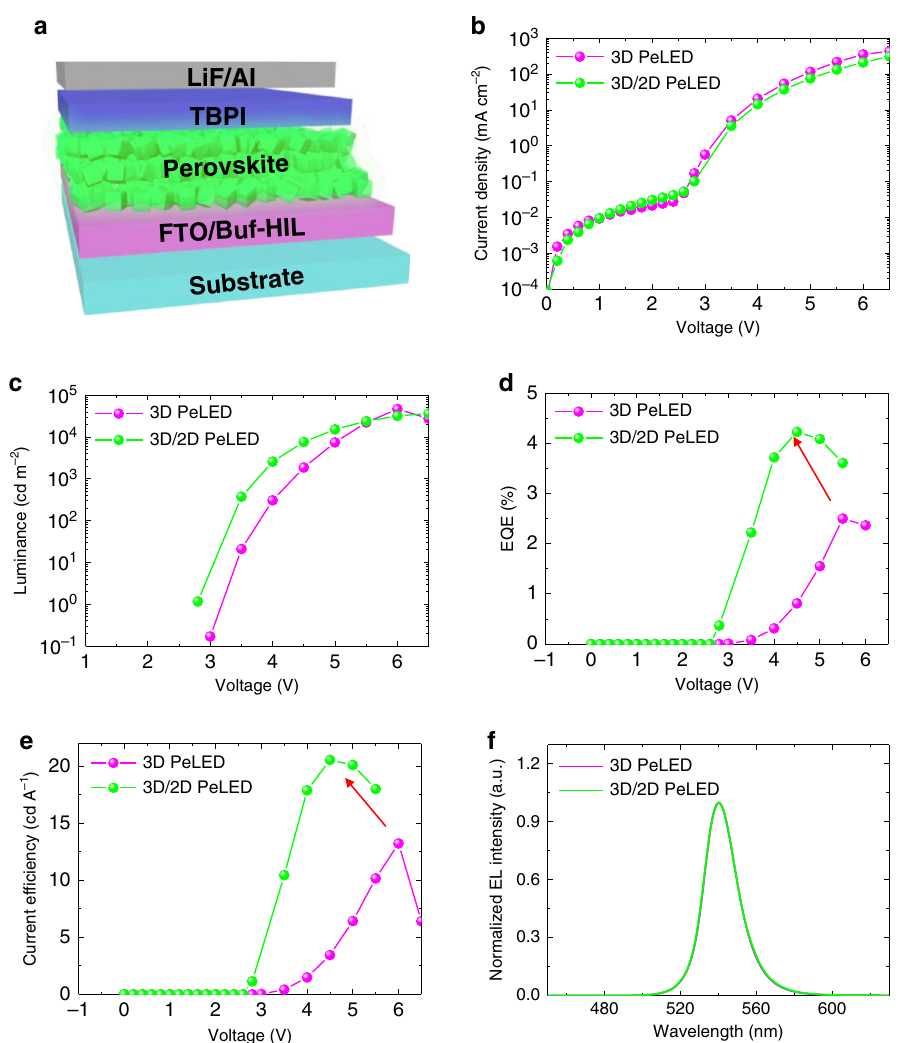
Fig. 6 EL characteristics of PeLEDs. a Device structure of PeLEDs. b Current density of PeLEDs as a function of applied voltage. c Luminance of PeLEDs as a function of applied voltage. d External quantum ef fi ciency (EQE) of PeLED as a function of applied voltage. e Current ef fi ciency (CE) of PeLEDs as a function of applied voltage. f Normalized EL spectra of